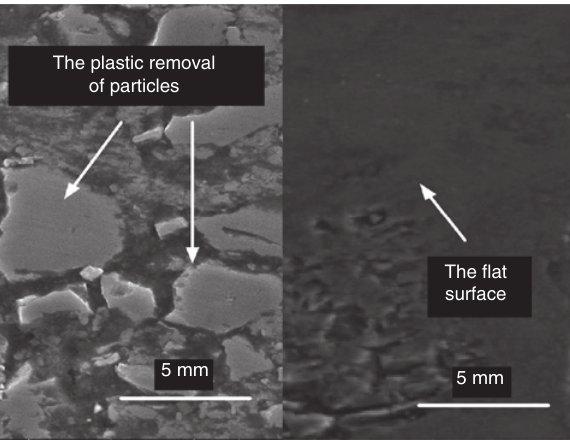
Figure 7: The ideal surface